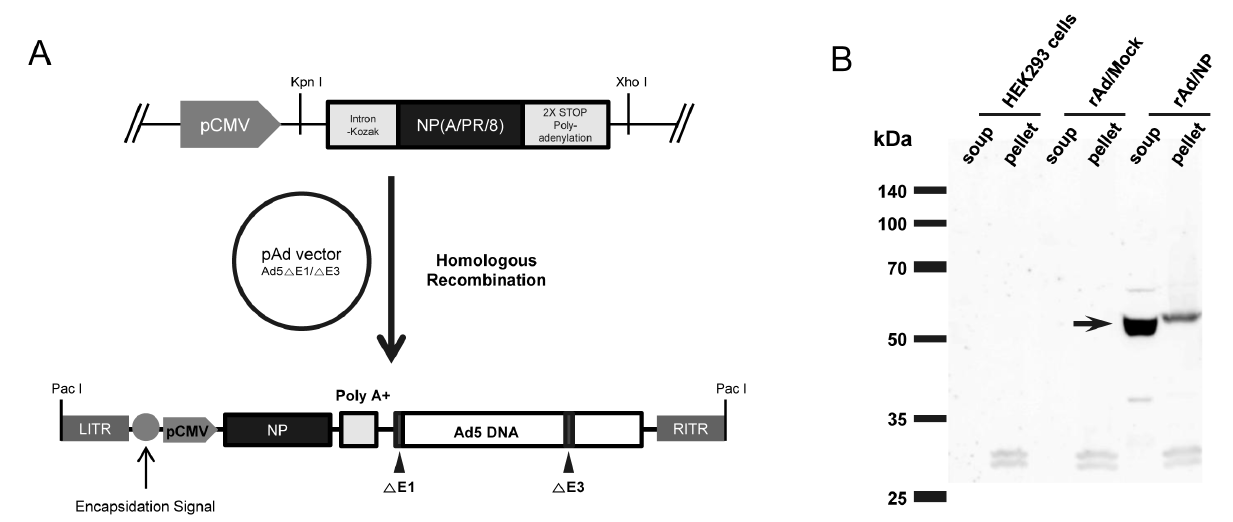
Figure 1. Generation of replication-defective adenovirus expressing NP gene of influenza virus (rAd/NP). (A) A schematic diagram of rAd/NP recombinant genome generated after homologous recombination between the shuttle vector and adenoviral genome. A shuttle vector plasmid containing NP gene of PR8 virus was constructed and recombined with the pAd-Easy vector (Ad5- △ E1/E3). (B) Expression of NP in the lysates of HEK293 cells infected with rAd/NP. The expression of NP (indicated by the arrow) was confirmed by immunoblotting assay as described in the Materials and